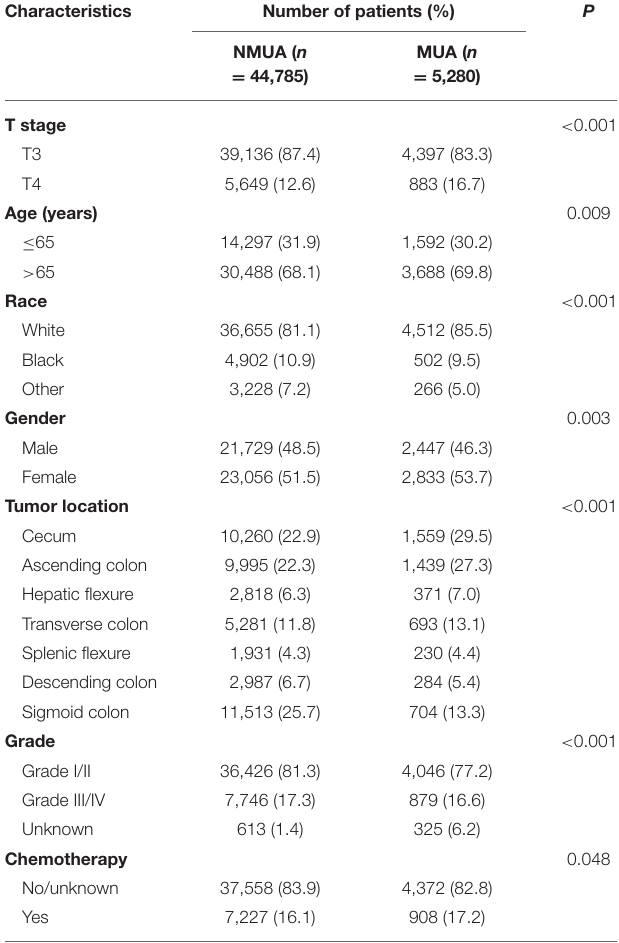
TABLE 1 | Demographic and patient characteristics according to the histology in stage II colon cancer.